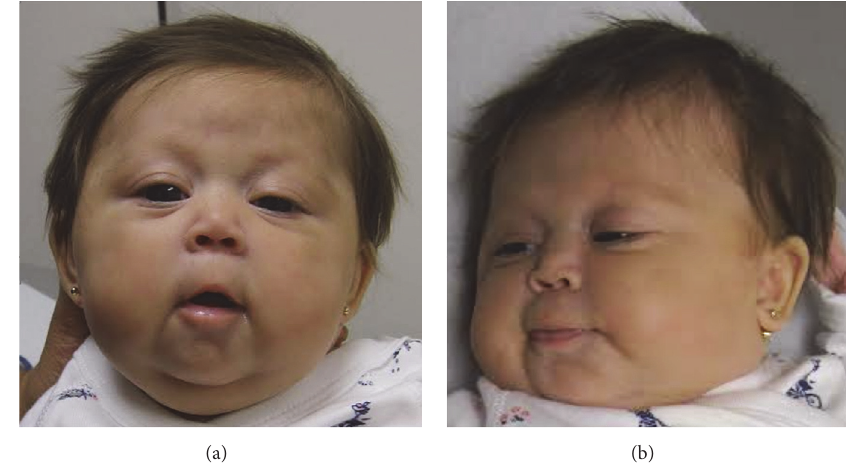
Figure 1: (a) Demonstration of round face, hypotelorism, and left-sided ptosis. (b) Demonstration of low set ear and flattened midface.